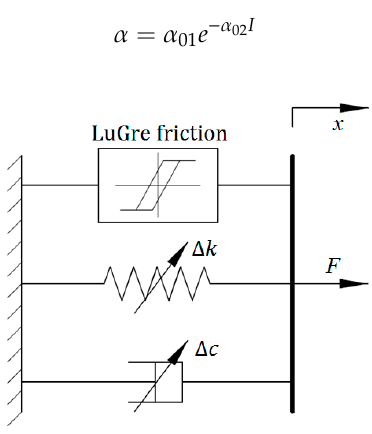
Figure 7. Improved LuGre friction model.